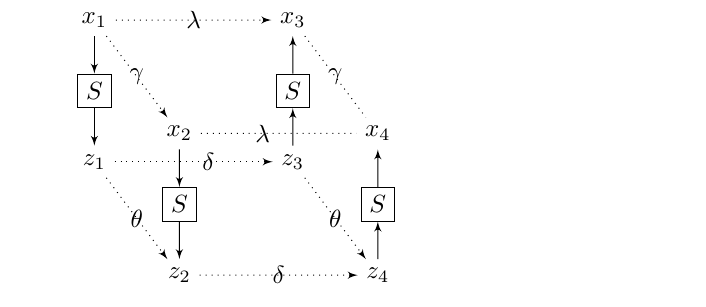
Figure 1: Differences used in the tables for a single layer of